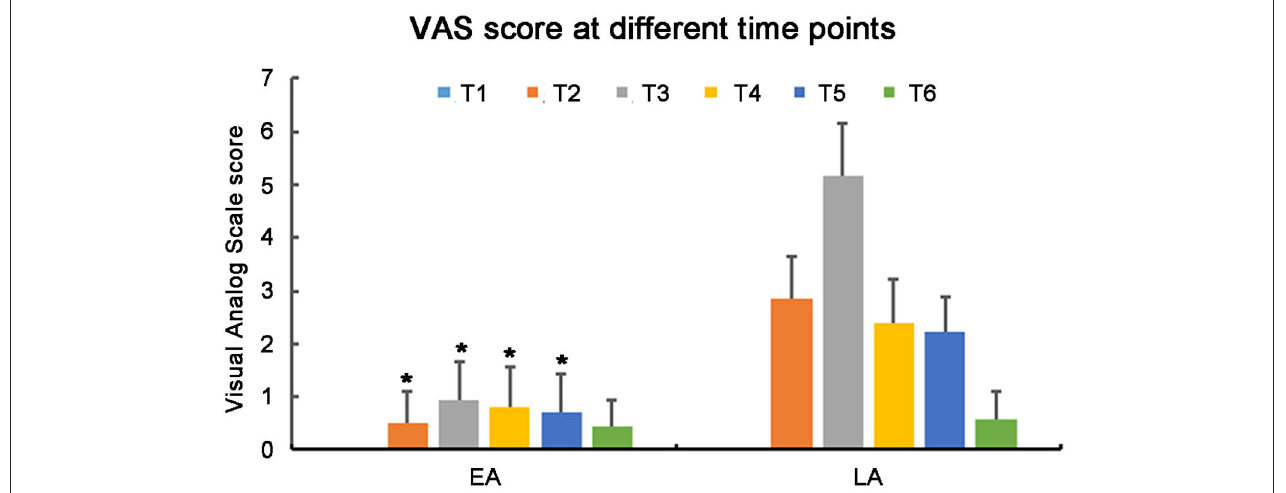
FIGURE 2 | Visual analog scale score in the EA group and LA group at different time points. EA, Epidural anesthesia; LA, Local anesthesia. * p < 0.001.